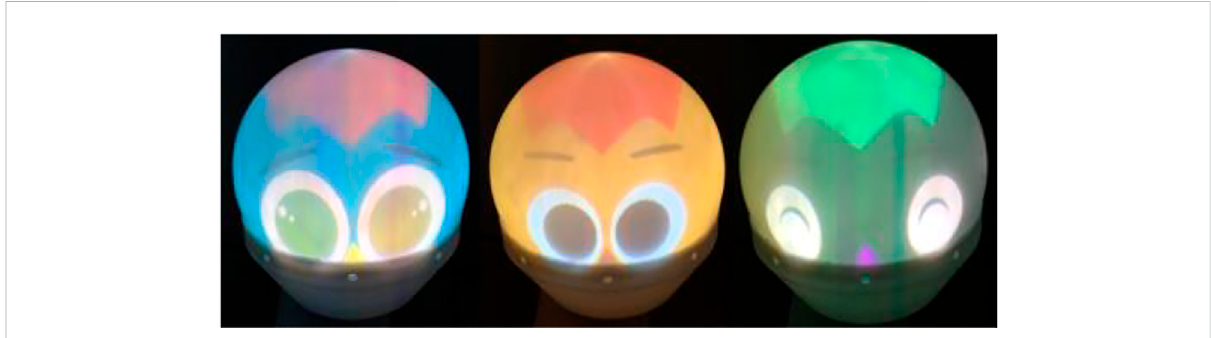
FIGURE 3 Color examples of UGA.